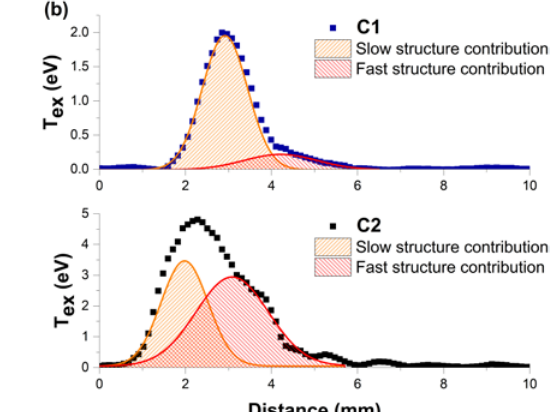
for both investigated plasmas ( b